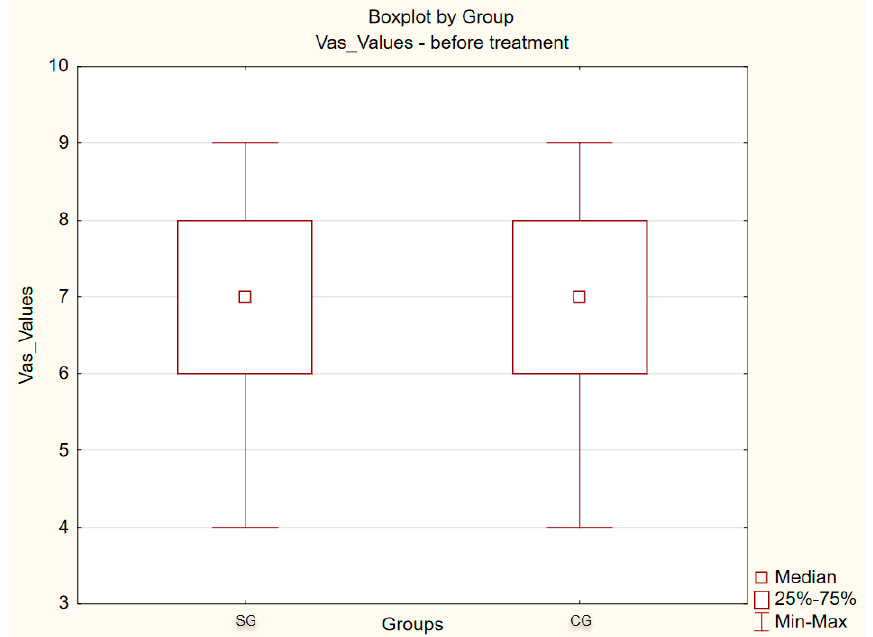
Figure 5. Results of VAS points before